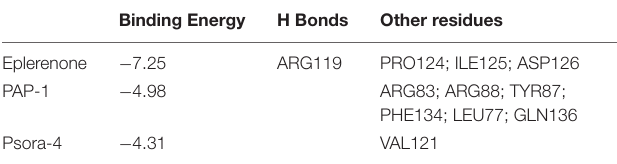
TABLE 3 | The scores of docking and the residues.